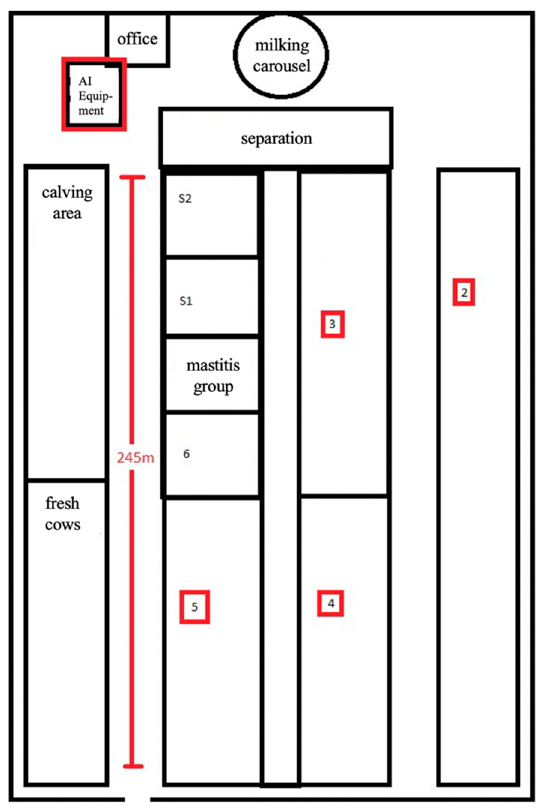
Figure 1. Schema of the experimental farm building. Areas relevant to the experiment are marked in red.